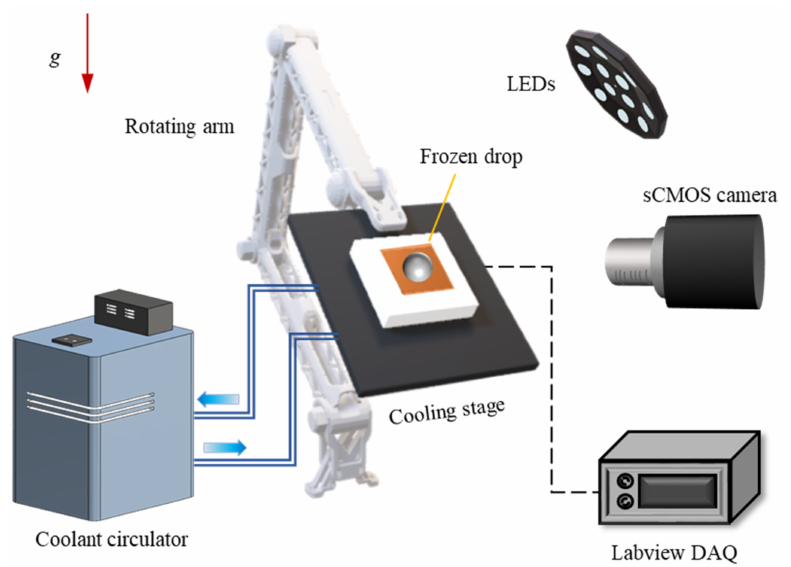
Figure 2. Schematic of the experimental setup. The substrate temperature, the ambient temperature, and relative humidity were maintained at − 15 ± 0.1 ◦ C, 18 ± 0.2 ◦ C, and 30 ± 5%,